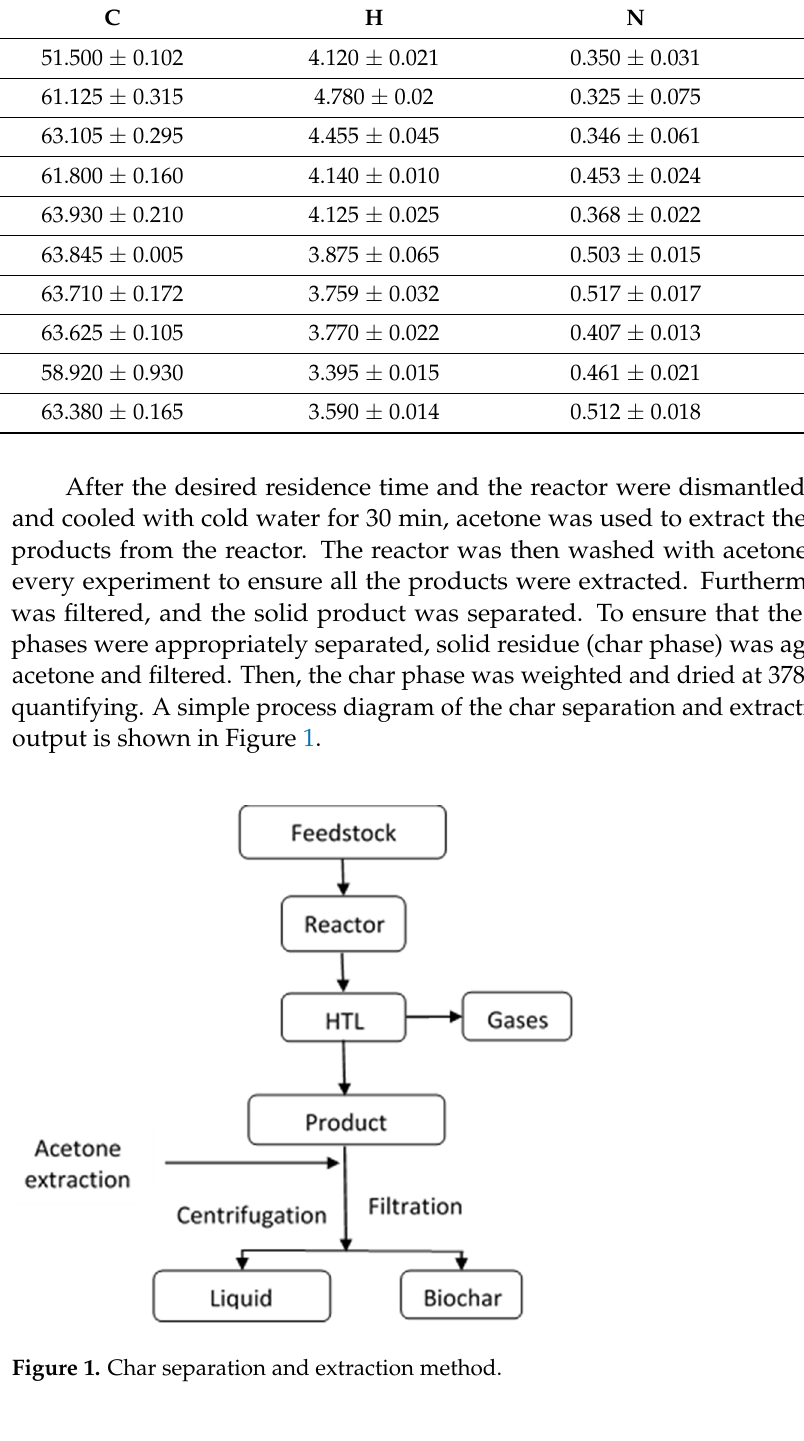
based on Equation (1) [19].